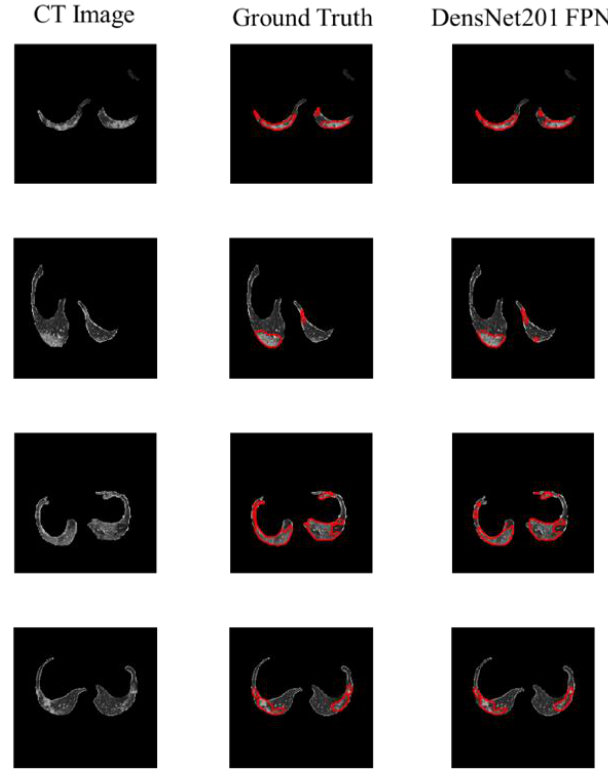
Figure 5. CT image (1st row), ground truth (2nd row), and the lesion segmentation of the top three networks (rows 3–5).